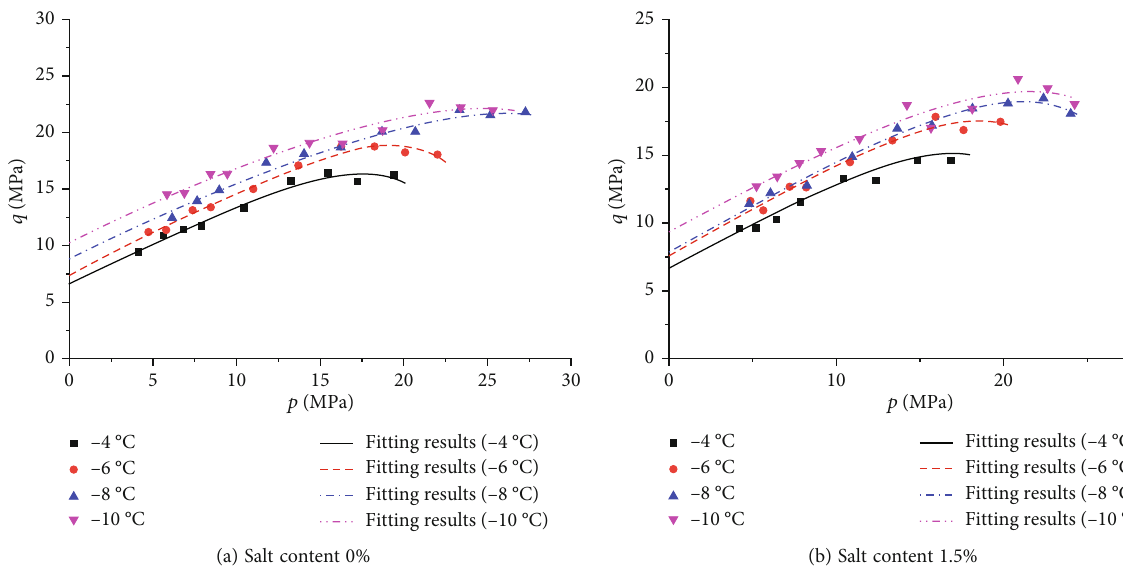
Figure 3: Fitting results of the proposed strength function in p ‐ q plane at di ff erent